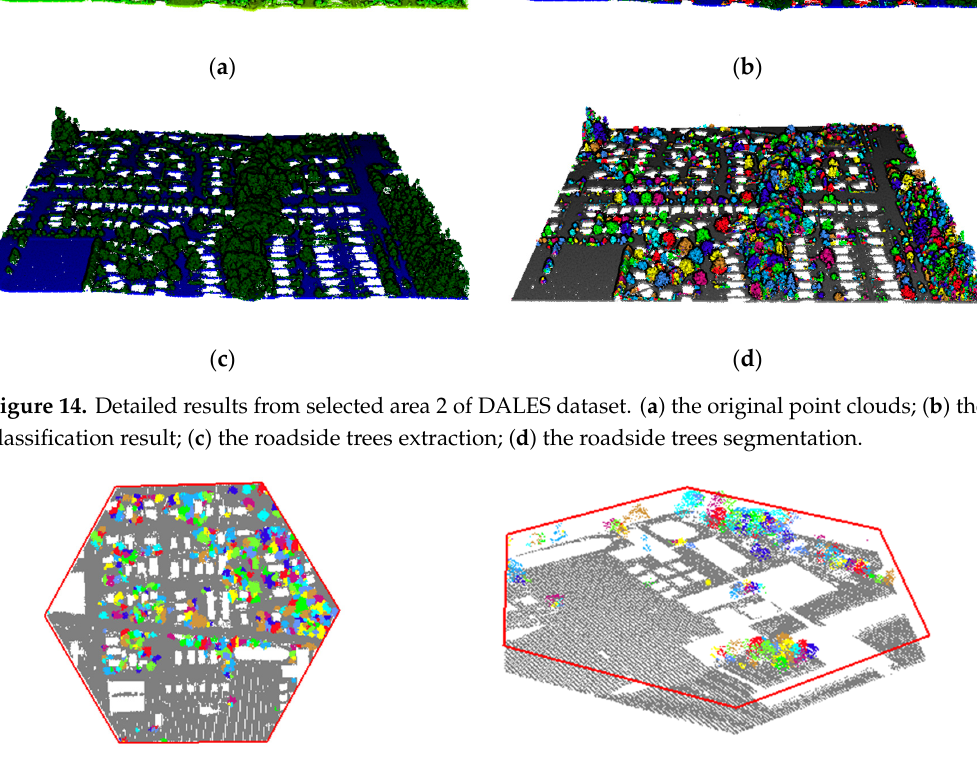
Table 7. Individual tree segmentation results of the DFC 3D and DALES datasets using our method (All values are in %).